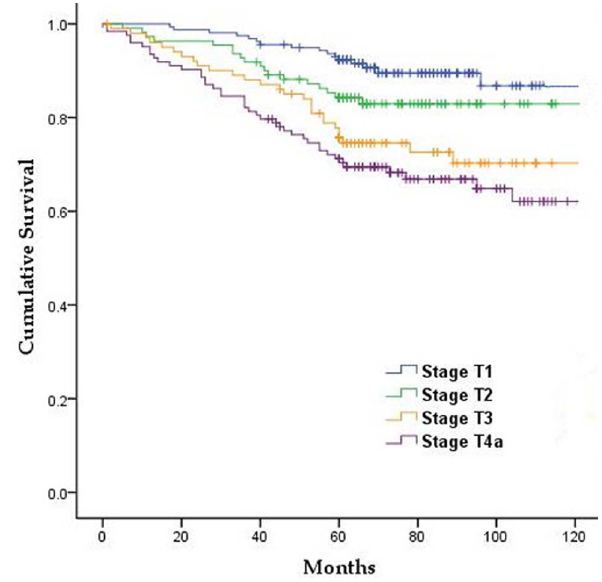
Figure 3. Survival curves of patients based on T stage.